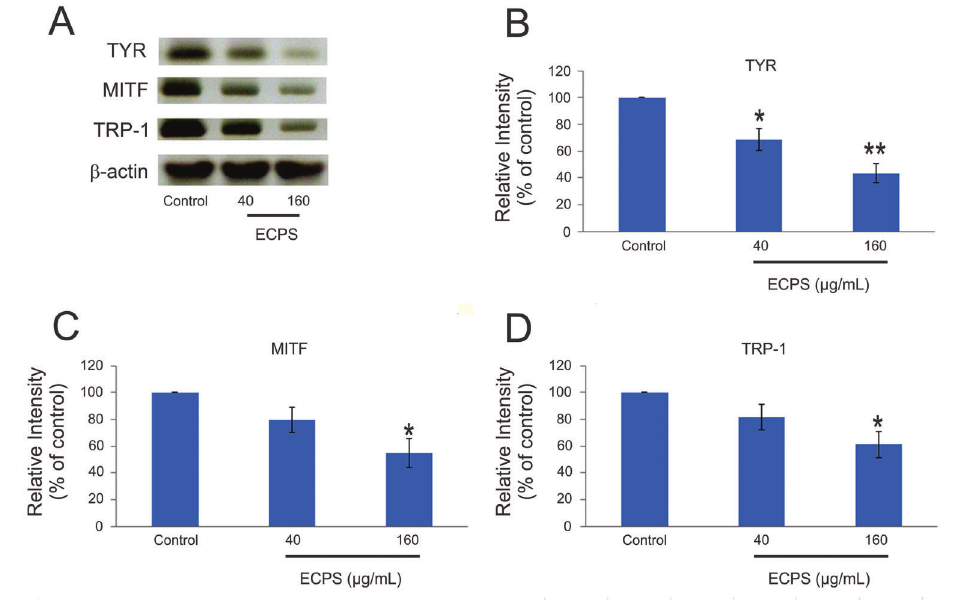
Figure 4. Protein levels of tyrosinase (TYR), microphthalmia-associated transcription factor (MITF) and tyrosinase-related protein (TRP-1) were examined by western blots ( A ). The ratios of TYP/ b -actin, MITF/ b -actin, and TRP-1/ b -actin are reported in panels B – D as means ± SD. *P o 0.05, **P o 0.01 compared to control group (ANOVA followed by Dunnett ’ s test). ECPS: enzymatically hydrolyzed Cuscuta chinensis